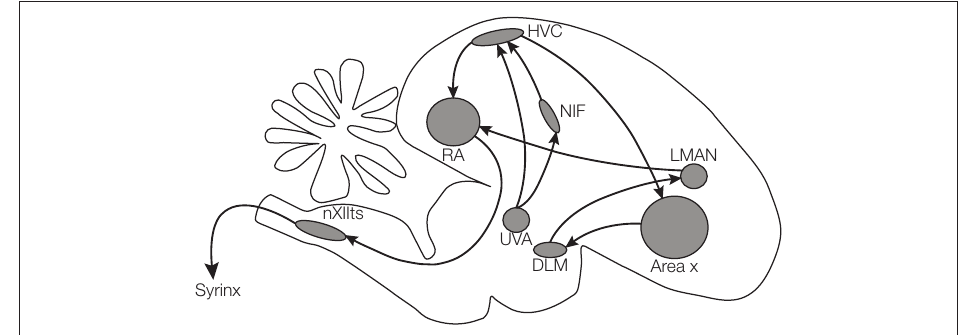
Figure 1 | Schematic drawing of the songbird brain, highlighting regions involved in song learning and song